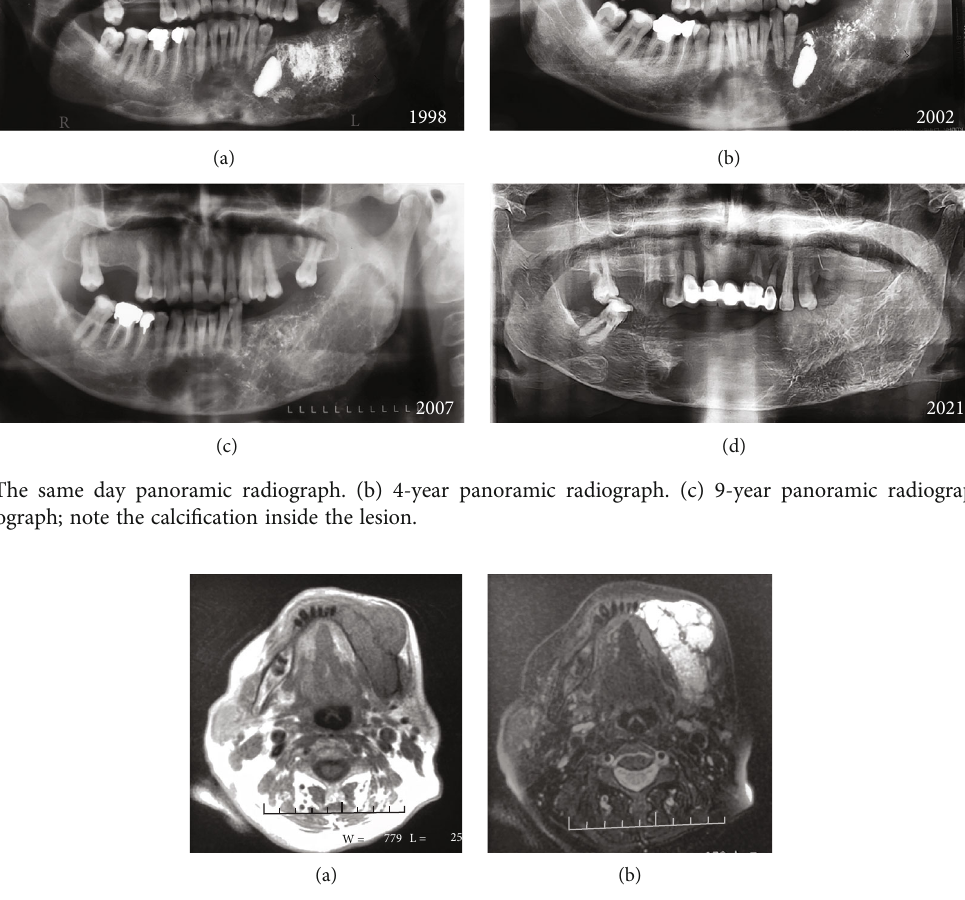
Figure 5: 10-year MRI images: (a) after an axial T1WI MR image showing the stabilization of the old lesion; (b) an axial T2WI image presented the same hypersignals and expansible